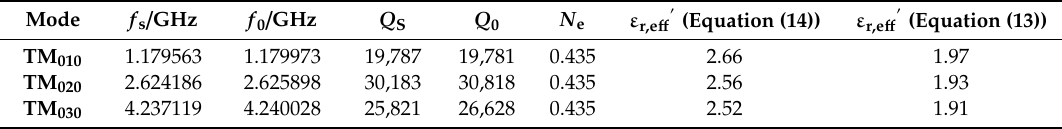
Table 2. Calculated dielectric constant of a ceria powder from simulation data with and without consideration of